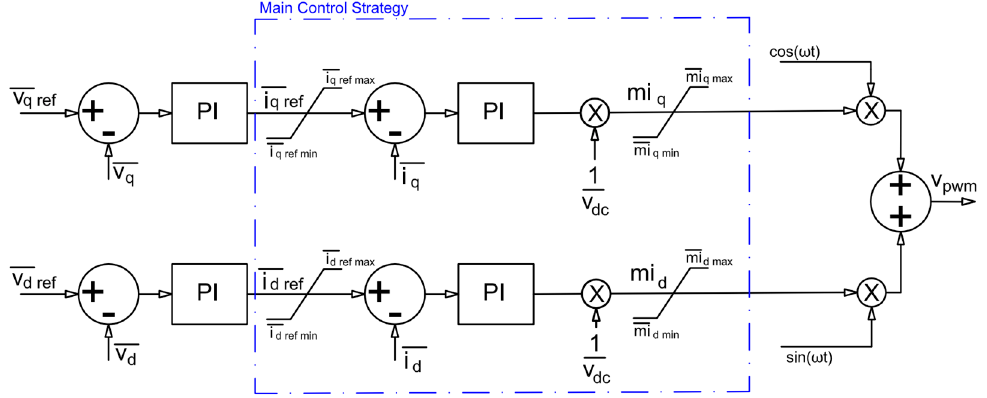
Figure 7. Control